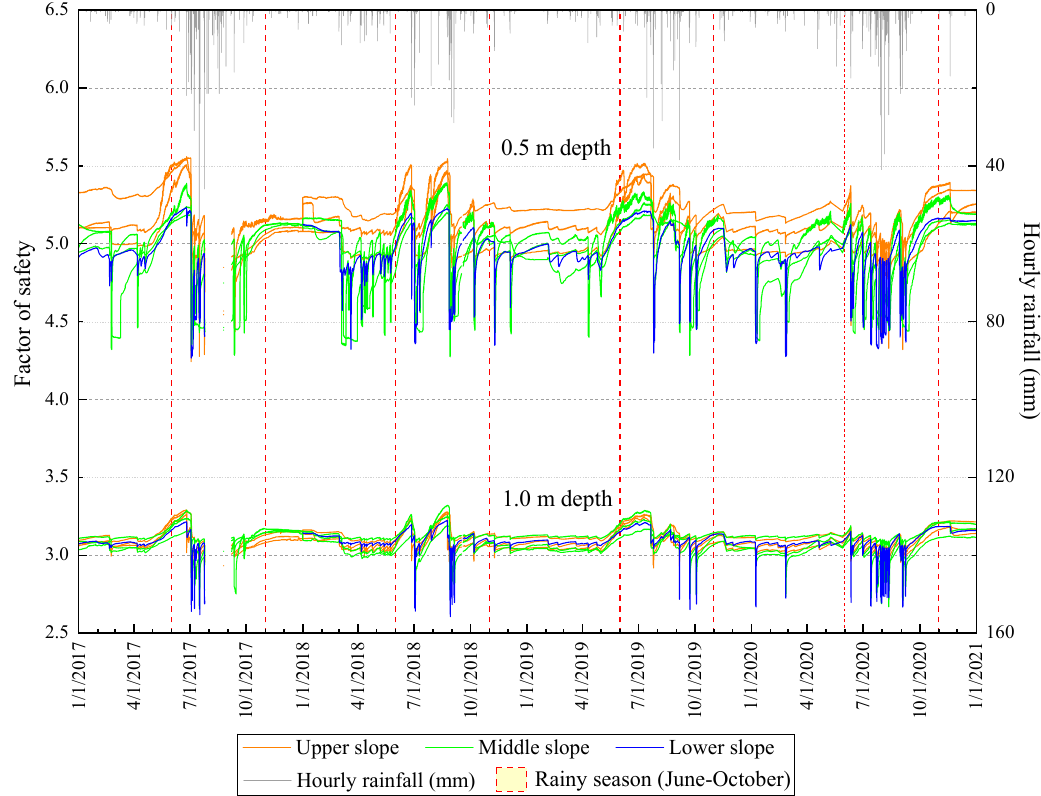
Figure 11. Four-year variations in the factor of safeties calculated at soil depths of 0.5 and 1.0 m at each of the three sections in the Songnisan landslide monitoring station.